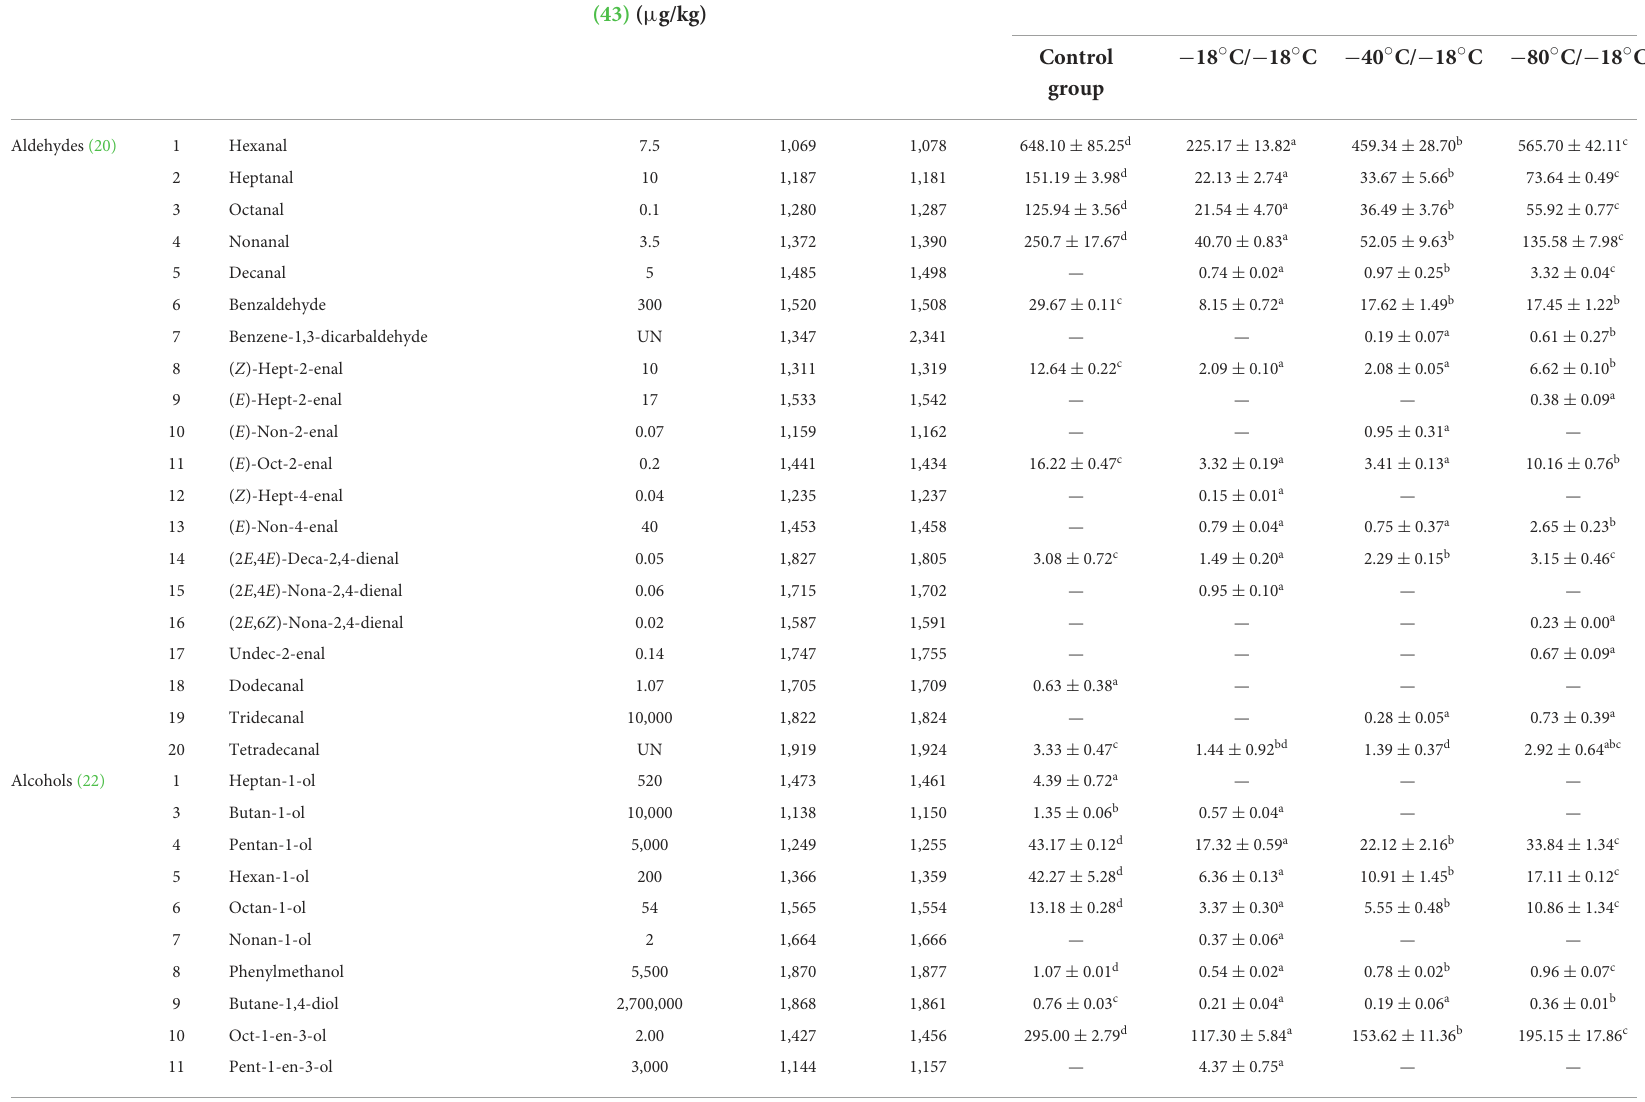
TABLE 2 Volatile flavor compounds of HGM with different freezing rates.